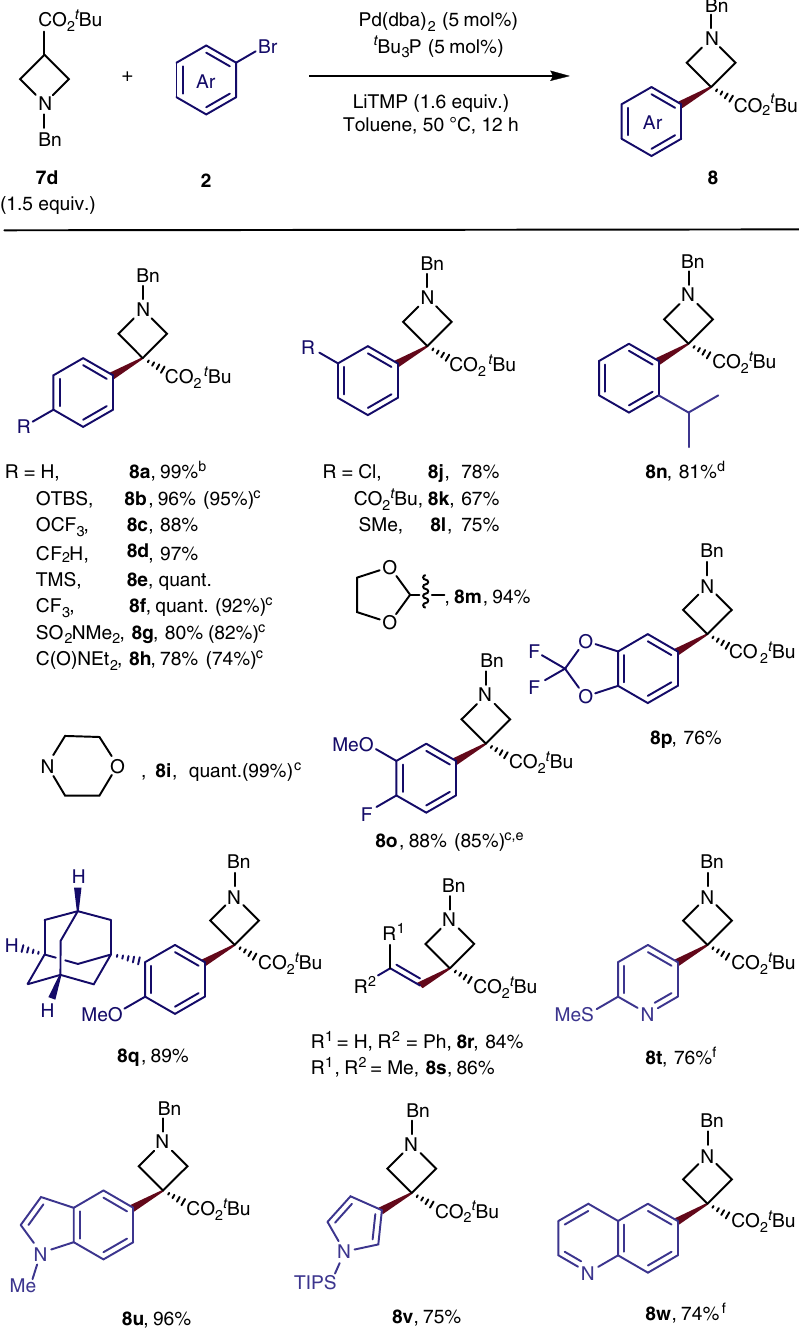
Fig. 4 Scope of α -arylation of azetidinyl t -butyl esters. a Isolated yields. b For PhCl use instead, 40% yield; For PhI used instead, 70% yield; For PhOTf used instead, no product. c Yield shown in the parentheses after 10 min. d 7d (2.0 equiv.), LiTMP (2.1 equiv.), [Pd] (10 mol%), t Bu 3 P (10 mol%) were used instead. e Half-gram scale test gave 85% yield. f 7d (2.0 equiv.), LiTMP (2.1 equiv.) were used coupling of the resulting amine with an aryl halide. The combination of acid-catalyzed cleavage of the N -Boc linkage and acylation with benzoyl chloride gave the N -benzoyl azetidine 16 , whereas cleavage and reductive amination with cyclopropane- carbaldehyde gave the N -cyclopropylmethyl azetidine 17 . Overall, the combination of α -arylation, conversion of the t -butyl ester to any of the functional groups accessible from an ester, and derivatization of the free nitrogen after deprotection generates an azetidine core containing a wide range of substituents at three positions.